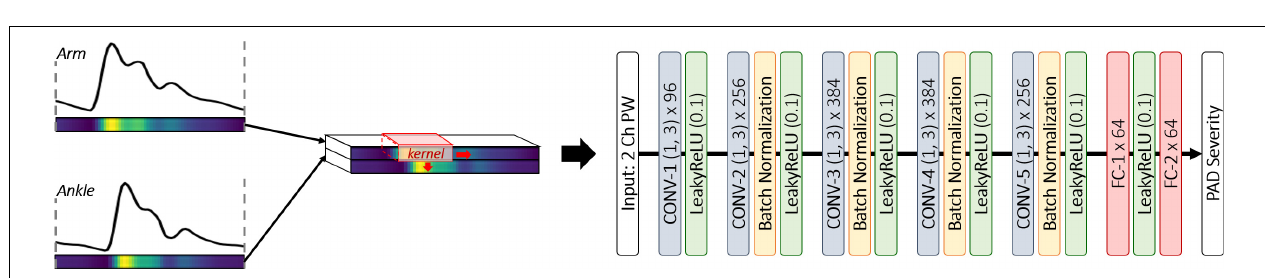
FIGURE 3 | Deep convolutional neural network (CNN) architecture for PAD diagnosis via deep learning-based arterial pulse waveform analysis. CONV- n ( h , l ) × k : n th convolution layer with height h , length l and the number of kernel k . LeakyReLU ( a ): LeakyReLU activation with slope a on negative inputs. FC- n × m : n th fully connected layer with the number of node m